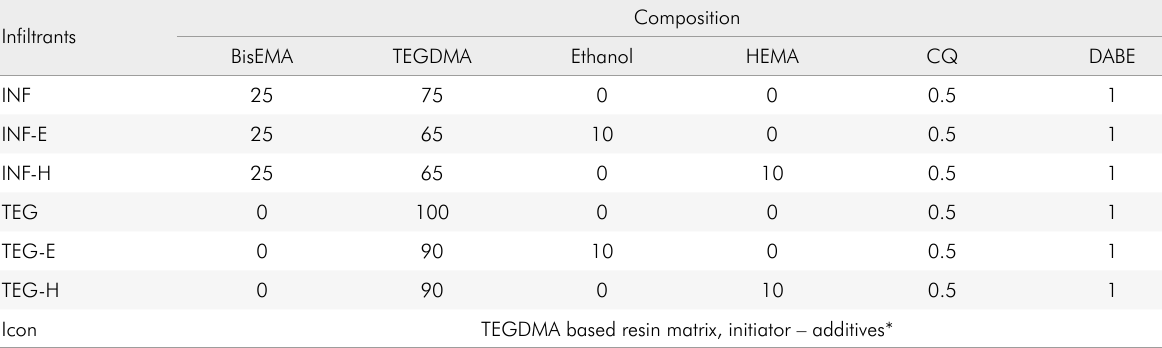
Table 1. Composition (weight percentage) of